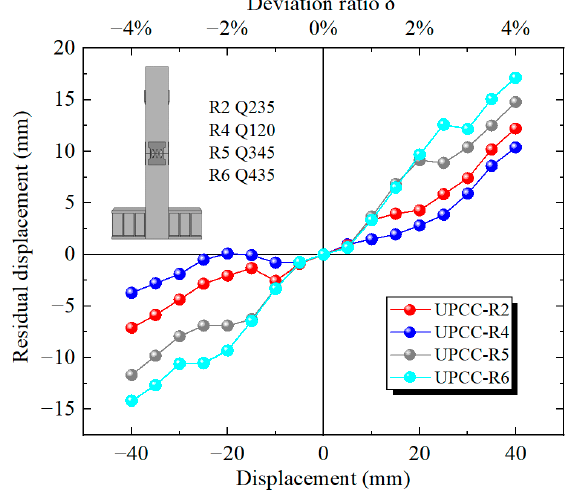
Figure 27. Residual displacement under different steel yield strength of EREDL.